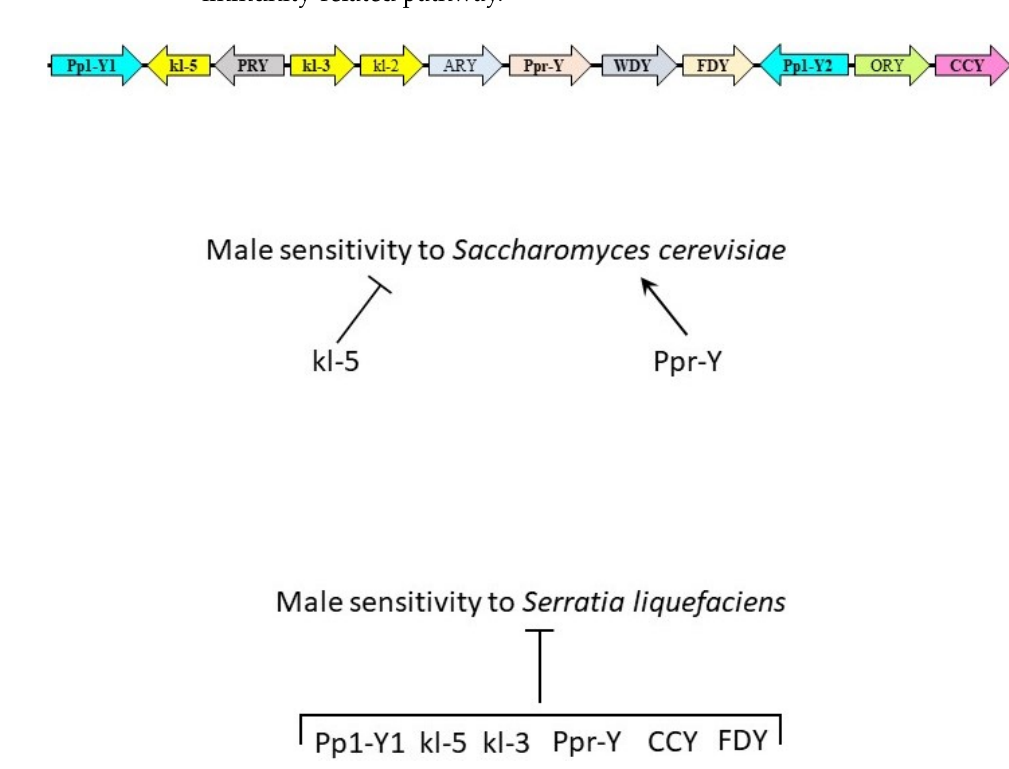
Figure 3. Genes of Drosophila melanogaster Y chromosome and their role in immunity. The Y chromosome of D. melanogaster consists of 12 single-copy protein-encoding genes. Loss of function of genes in bold were studied during fungal and bacterial oral infection assays. During Saccharomyces cerevisiae challenge, kl-5 and Ppr-Y decrease and increase the sensitivity of male flies to infection, respectively. Pp1-Y1, kl-5, kl-3, Ppr-Y, CCY, and FDY were found to decrease male sensitivity to Serratia liquefaciens oral infection.